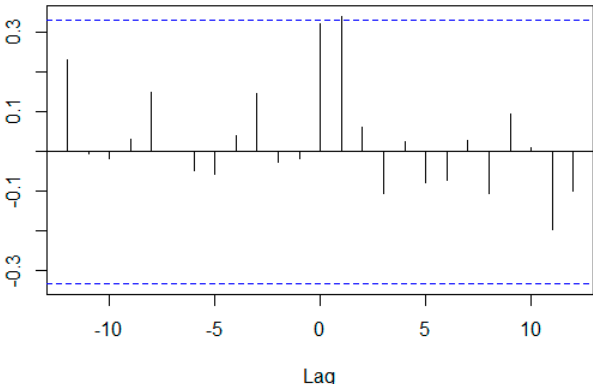
Figure 4. Cross-correlation coefficient between the average CAR of the camera group and the average CAR of the display group for Evaluation period: 2007–2008, Event period: 2010–2012.